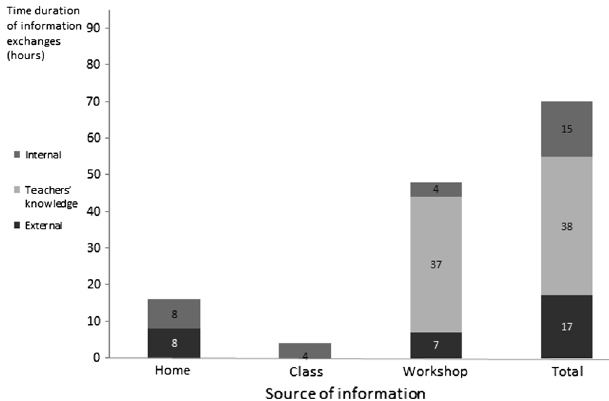
FIG. 3. Workshop A (minimal guidance): Information ex- changes by source of information and